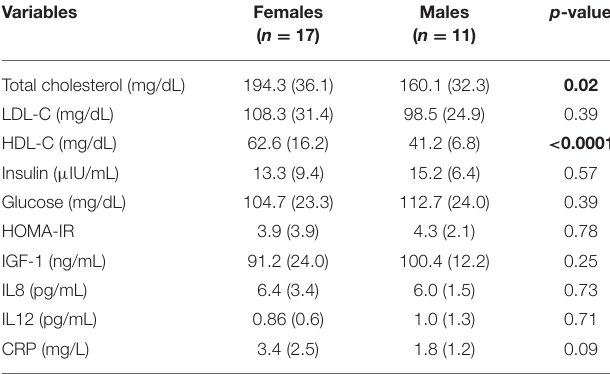
TABLE 2 | Baseline cardiometabolic characteristics separated by